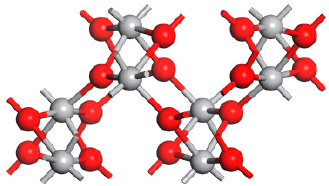
Figure 1. The bulk structure of TiO 2 brookite. The grey spheres represent Ti atoms while the red spheres represent O atoms.